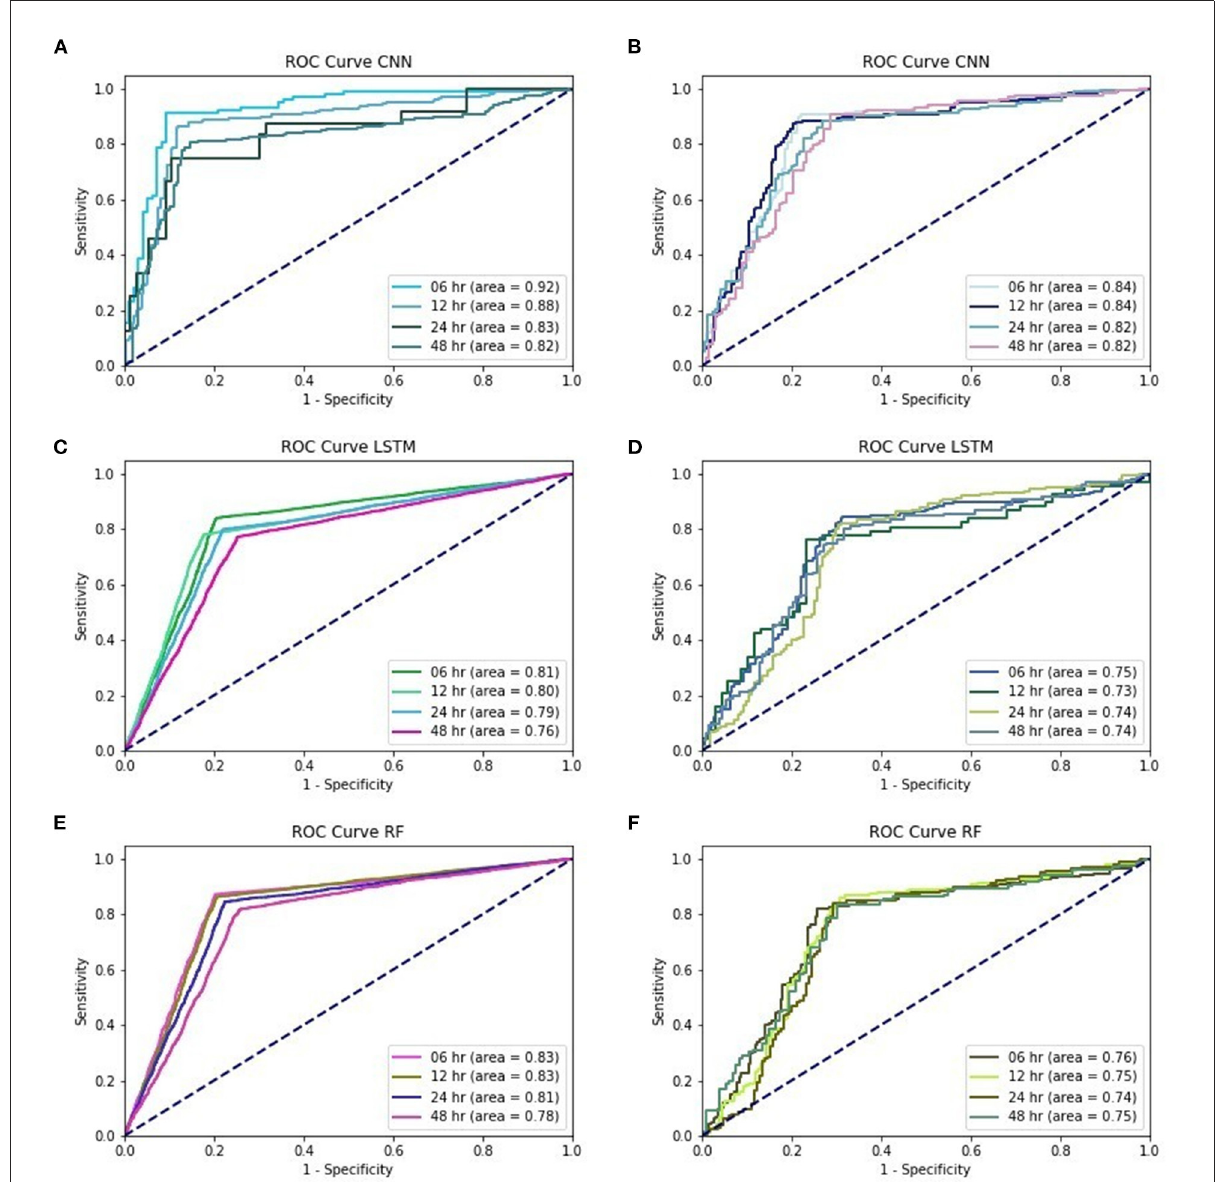
FIGURE1 (A) training performances of ROC curve in EWS_C, (B) testing performances of ROC curve in EWS_C, (C) training performances of ROC curve in EWS_L, (D) testing performances of ROC curve in EWS_L, (E) training performances of ROC curve in EWS_R, (F) training performances of ROC curve in